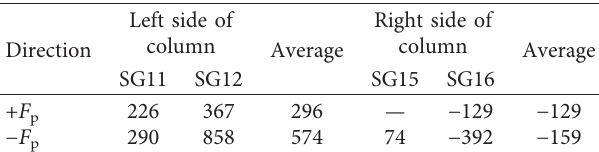
Table 12: Transverse strain of type-II sleeve in YZ2 at the peak state ( με